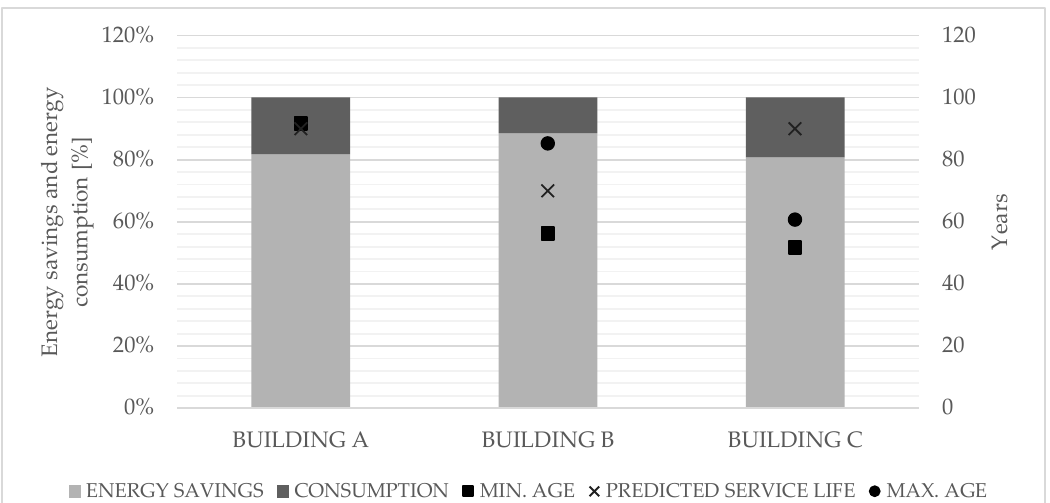
Figure 3. The range of energy savings and predicted service life.